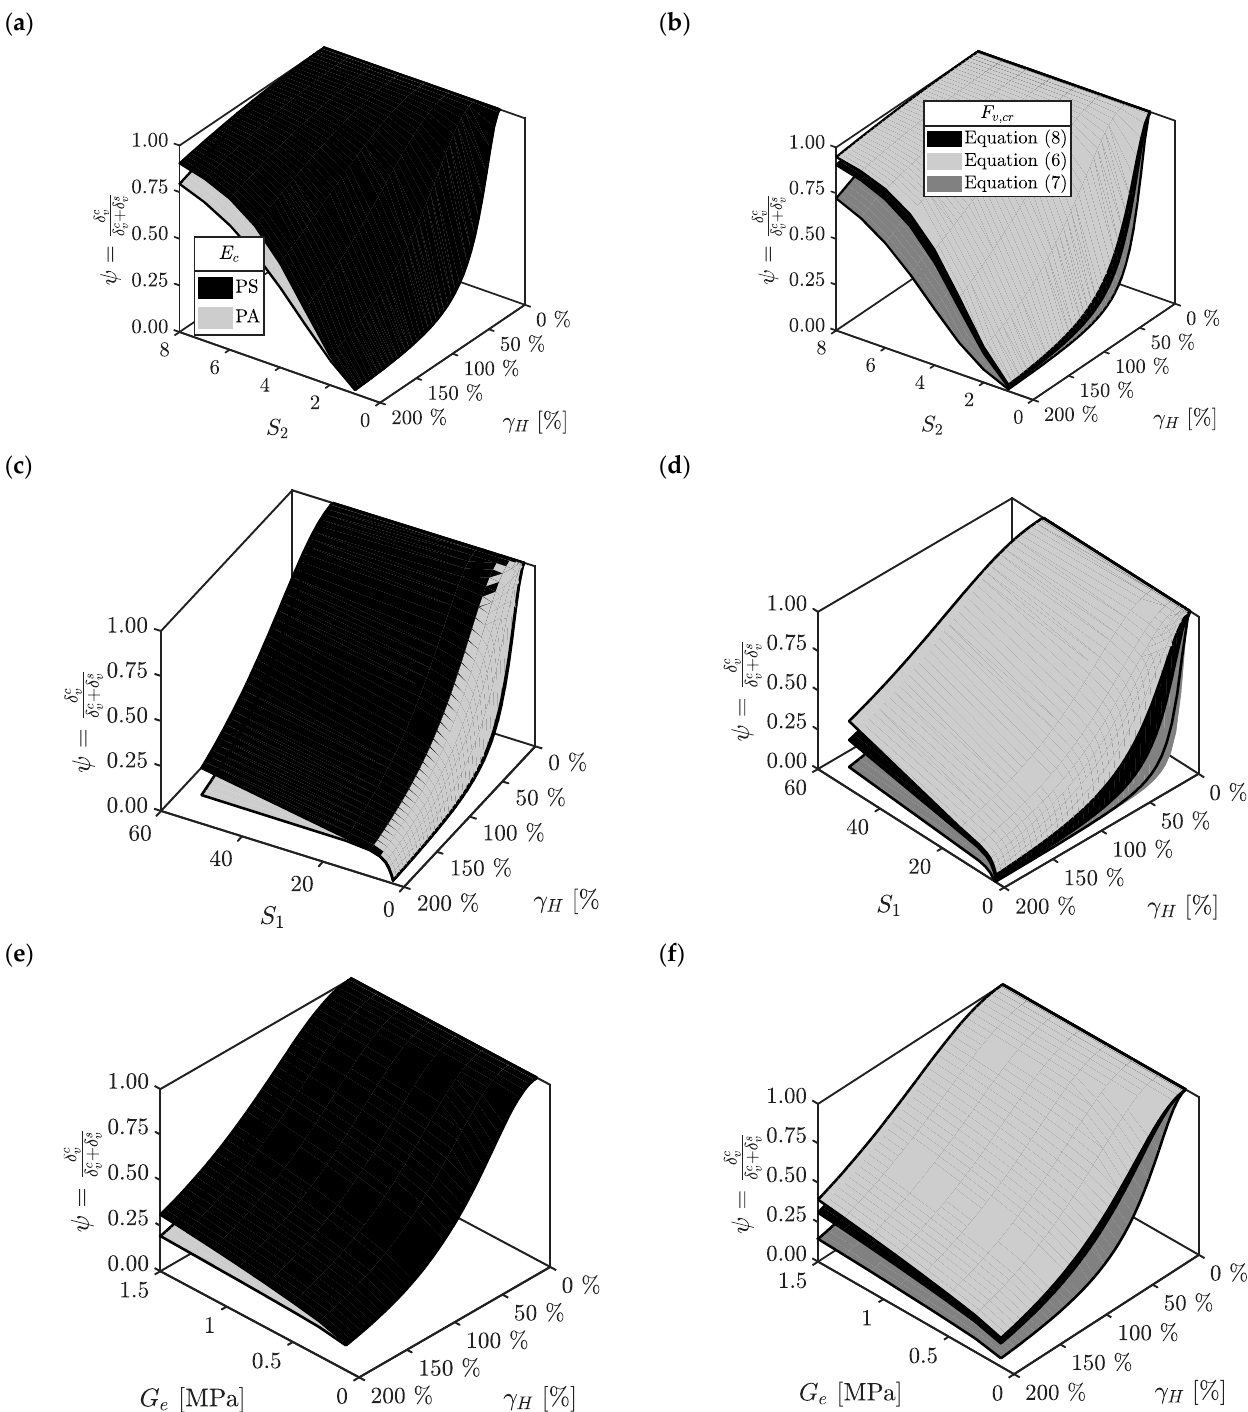
Figure 2. Trends of the ψ function with the horizontal deformation and: ( a , b ) secondary shape factors; ( c , d ) primary shape factor; ( e , f ) shear modulus of the rubber.